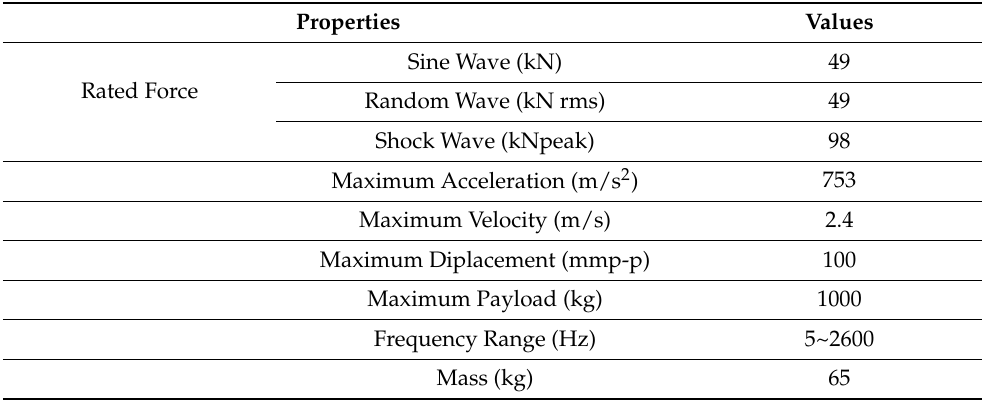
Figure 7. Natural frequency and durability experiments for chuck adapter testing equipment. ( a ) High-amplitude vibration, and ( b ) natural frequency experiment. Table 5. Vibration tester